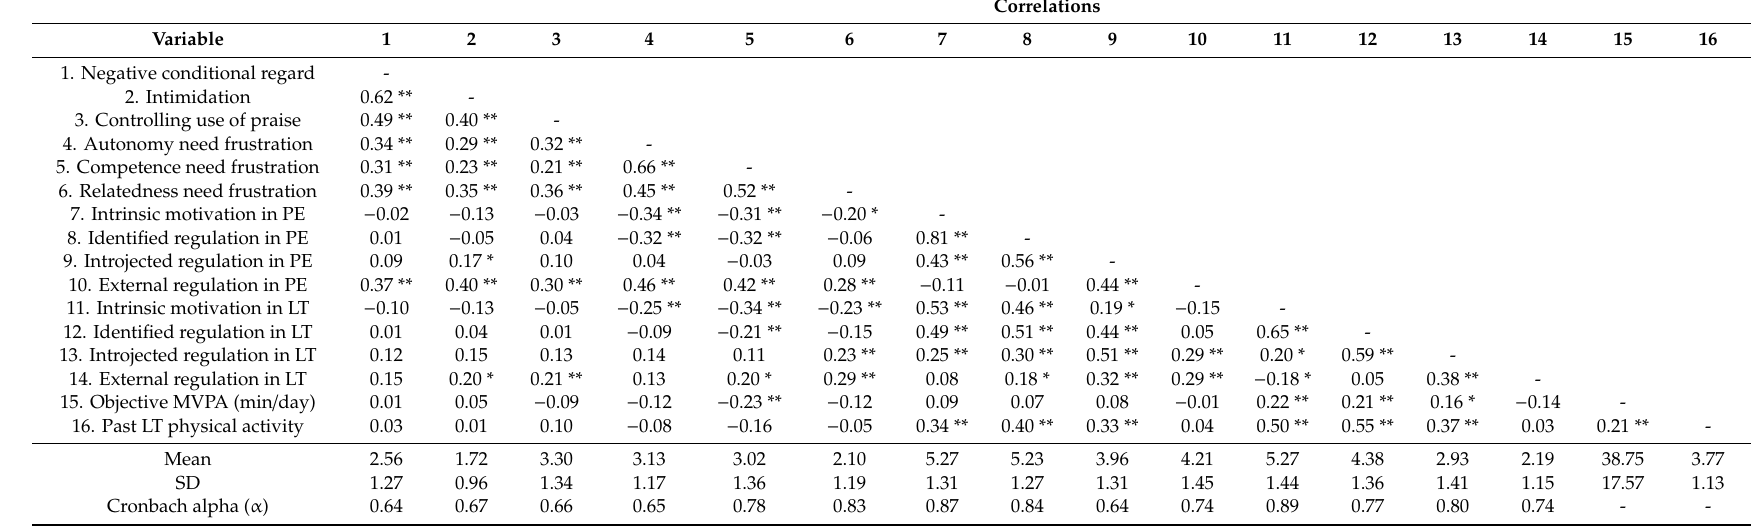
Table 1. Descriptive statistics, Cronbach’s alpha coe ffi cients, and correlations among study variables.